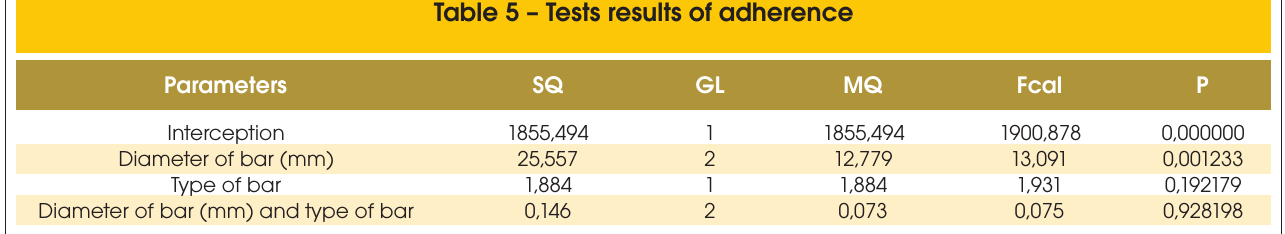
Table 5 – Tests results of adherence